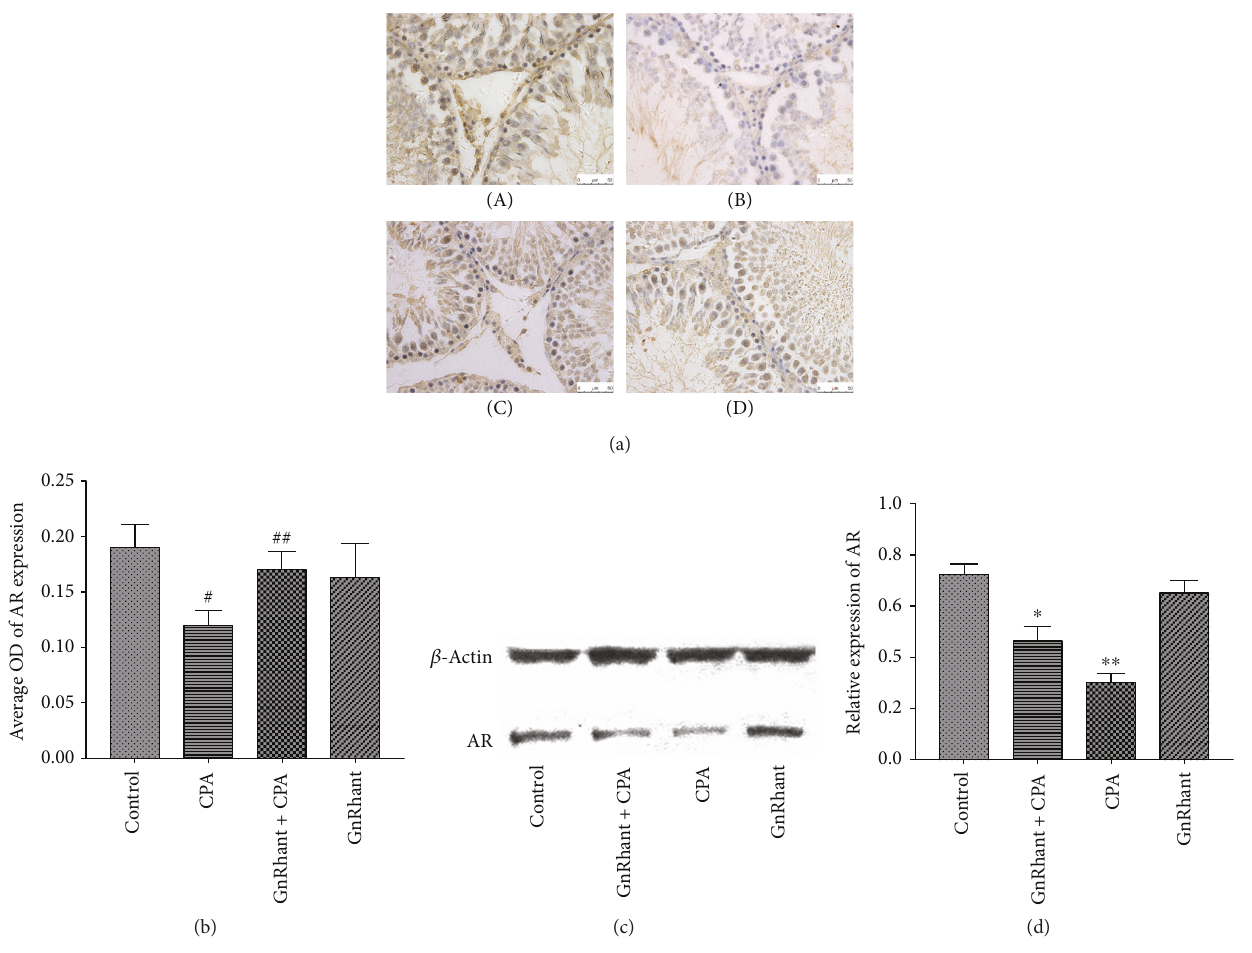
Figure 2: Representative photomicrograph of AR immunochemistry and Western blot assays in the testis. (a) (A) The control group showed strong AR immunostaining in the Sertoli, Leydig, and peritubular myoid cells. (B) The CPA group showed markedly decreased AR expression. (C) The GnRHant+ CPA group showed relatively restored AR expression. (D) The GnRHant group showed the same strong AR expression as the control group. (A, B, C, and D × 400). (b) Quantitative analysis of AR expression by immunohistochemistry in the testis. # Signi fi cantly di ff erent from the other three groups ( p < 0 001 ). ## Much higher than that in the CPA group ( p < 0 001 ). (c) Representative photographs of Western blot for AR protein expression. (d) Quantitative analysis of AR expression by Western blot in the testis. ∗ p < 0 001 compared with the other three groups ( p < 0 001 ). ∗∗ p = 0 03 , compared with the GnRHant+ CPA